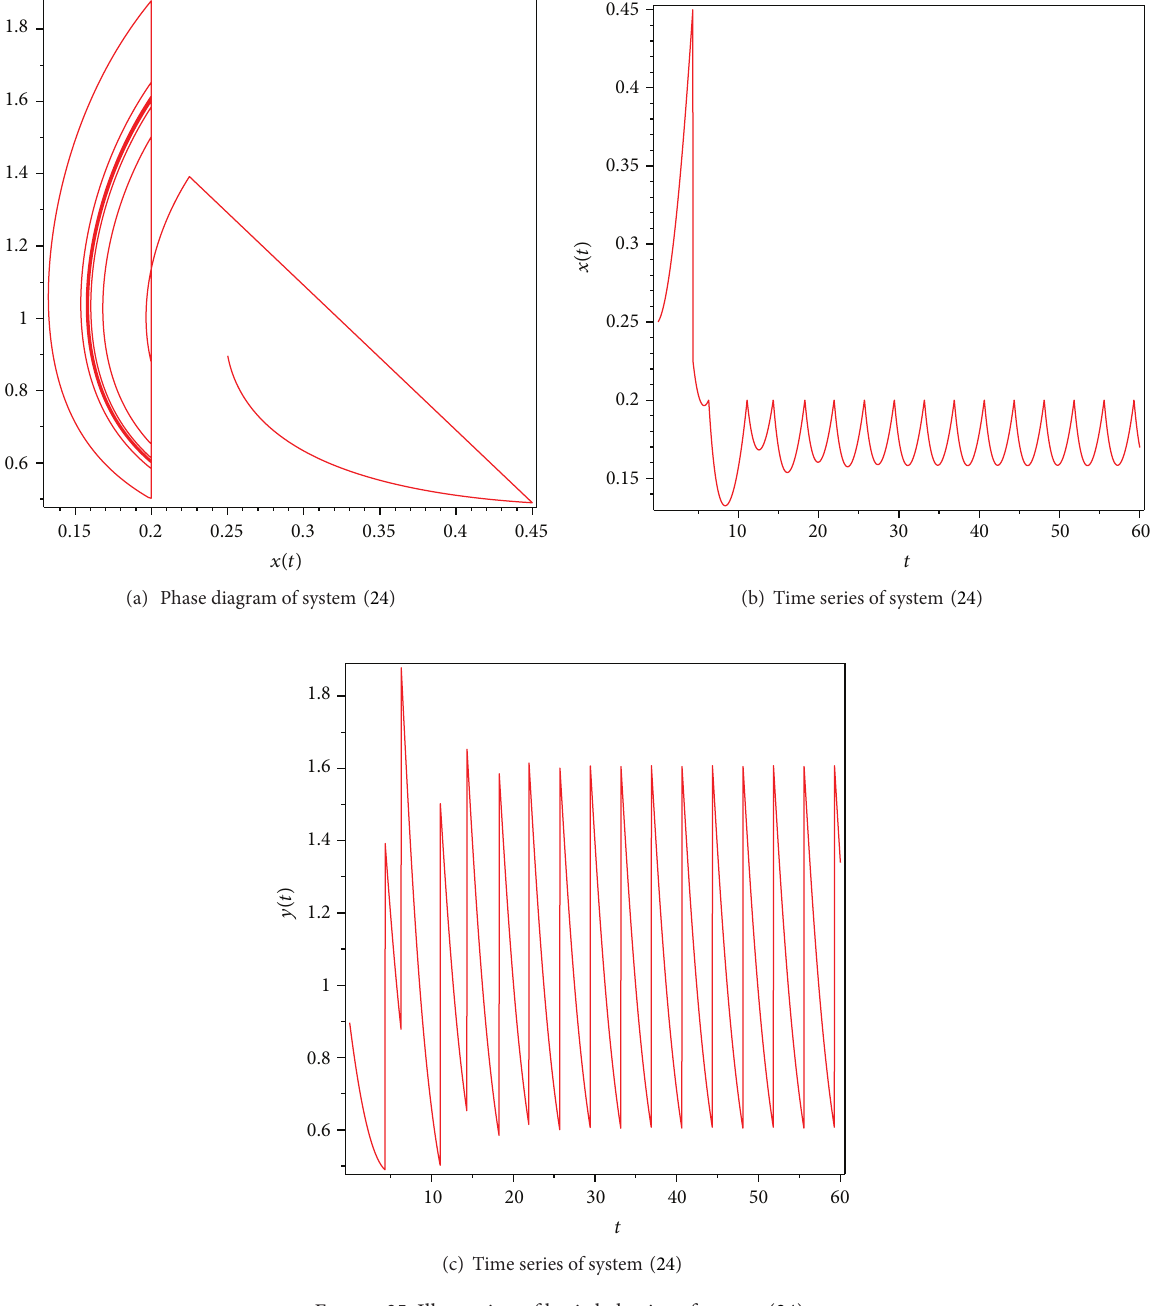
Figure 25: Illustration of basic behavior of system